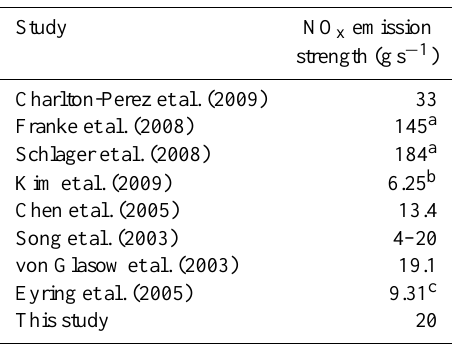
Table 3. Summary of NO x ship emissions strengths currently used in